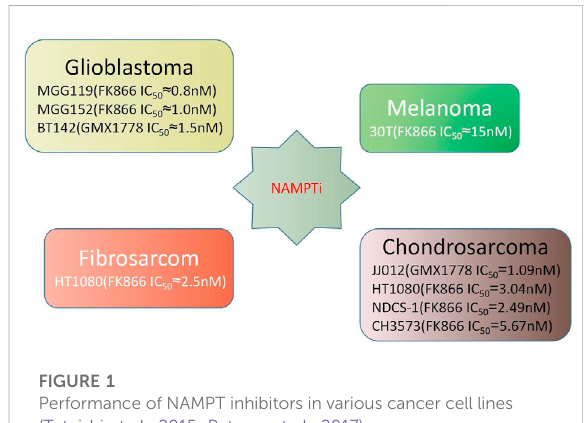
FIGURE 1 Performance of NAMPT inhibitors in various cancer cell lines (Tateishi et al., 2015; Peterse et al.,